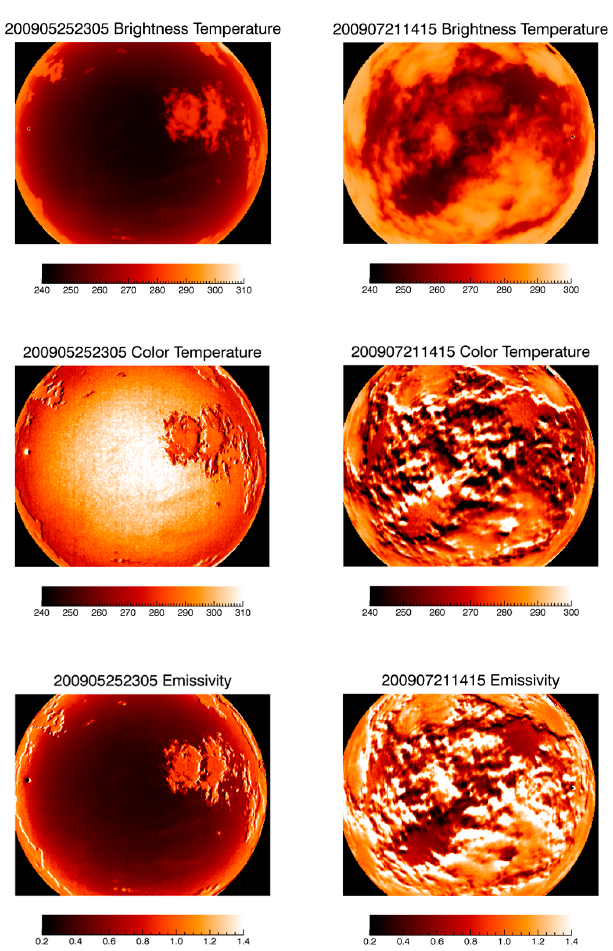
Fig. 10. Brightness temperature (K, top), color temperature (middle), and emissivity (bottom) for representative images for 25 May 2009 (left) and 21 July 2009 (right).